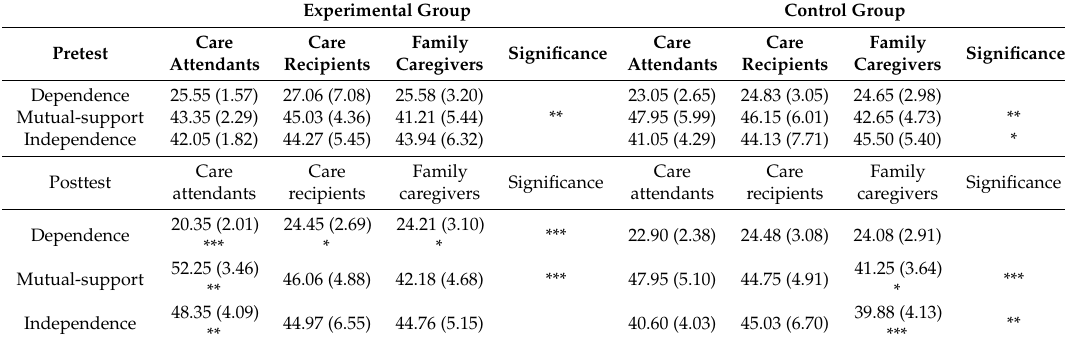
Table 4. Pretest and post-test of the self-reliance home care scale rated by the care attendants, home care recipients, and family